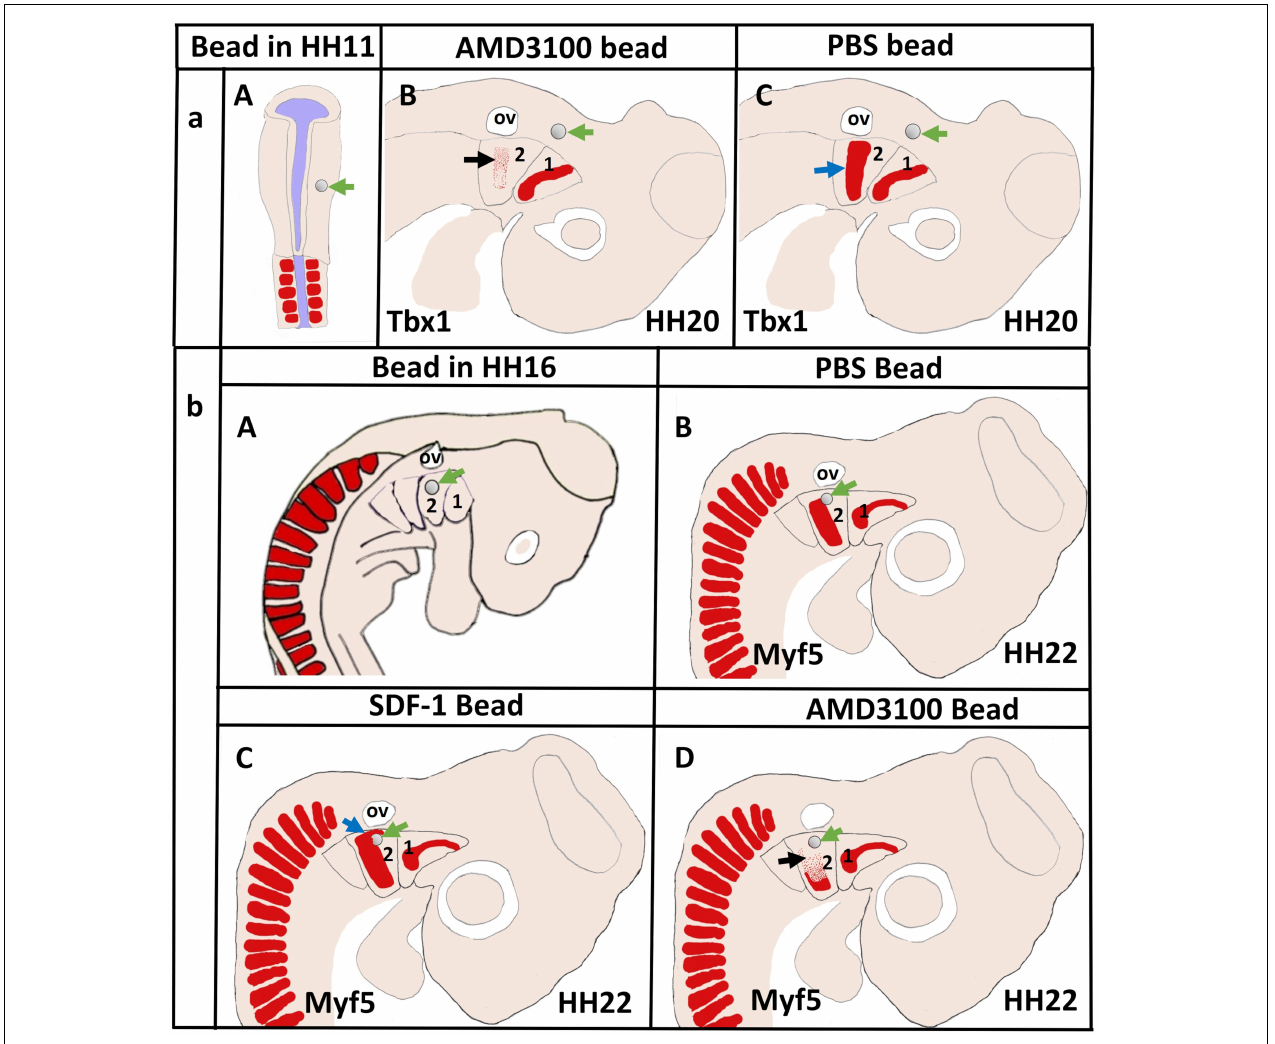
FIGURE 6 | Disruption of CXCR4 signaling in the early head mesoderm and BA2 inhibits migration of the BA2-mesodermal progenitor cells. (aA) Schematic representation of chicken embryo at HH11 implanted with beads soaked with the CXCR4 inhibitor AMD3100 or with PBS in head mesoderm. The embryos were re-incubated until they reached stages HH20 and hybridized with a Tbx1 probe. (aB,aC) Schematic representation showing the head region and the location of mesodermal cells in the BA2 at HH20. Tbx1 expressing area in the BA2 (black arrow) was diminished in AMD3100-treated embryos (B) in comparison with the PBS-treated embryos (C) . (bA) Schematic representation of embryo at HH16 implanted with beads soaked with the AMD3100 or with SDF-1 in head mesoderm. PBS bead used as control. Myf5 − expressing region (blue arrow in bC ) was increased in SDF-1-treated embryo. The BA2 myogenic core region (black arrow in bD ) was reduced in AMD3100-treated embryos, but not in PBS-treated embryos (bB) . Green arrows show the location of the implanted